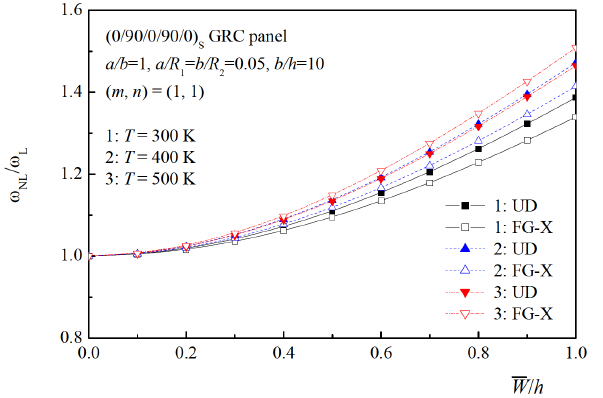
Figure 4: Influence of temperature variation on the frequency- amplitude curves of doubly curved (0/90/0/90/0) S GRC laminated panels